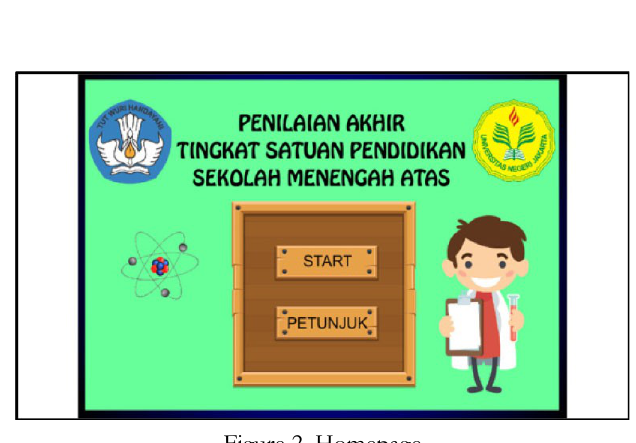
Figure 2. Homepage